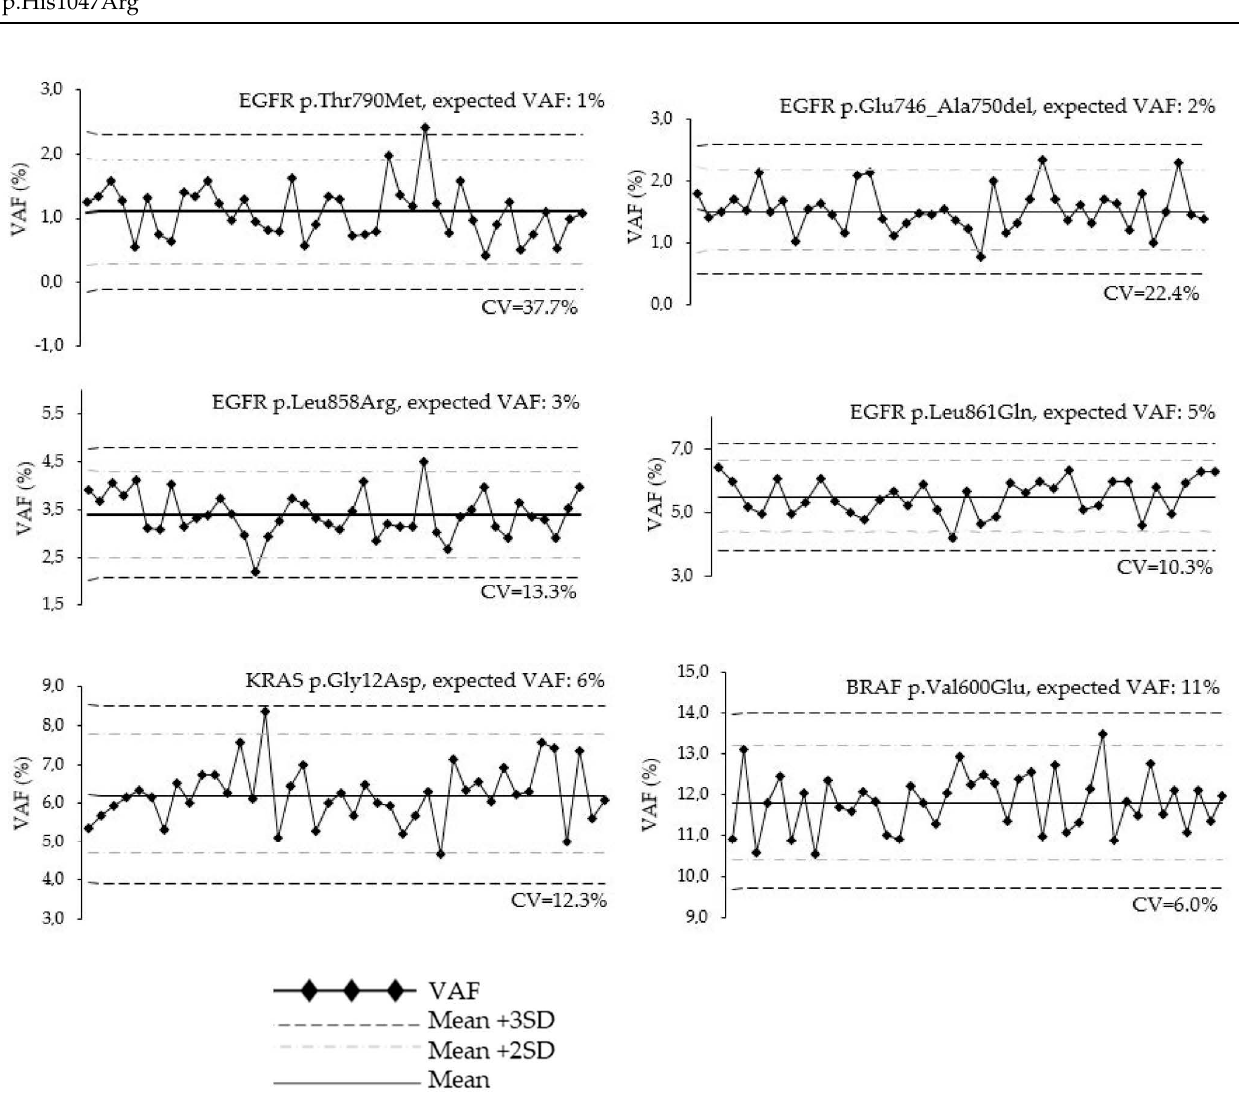
Figure 2. LeveyJennings plots of VAF obtained for six representative variants from HD200 and HD300 QC materials on S5XL instrument over a 21-month follow-up period. These data were also compared to a similar inter-run variability study performed using the THS on the Miseq instrument (HD300: n = 42 runs; HD200: n = 43 runs). The comparison of the VAF obtained for expected variants indicated a strong correlation between both methods (Pearson’s r = 0.990) (Table 1). To further evaluate inter-run variability, clinical samples from colorectal and lung tissues were analyzed within six different runs. Indeed, PIK3CA p.His1047Arg, EGFR p.Leu747_Ala750del, AKT1 p.Gly17Leu, BRAF p.Val600Glu, and KRAS p.Gly12Val mu- tations previously detected using the THS assay were called at each run using the